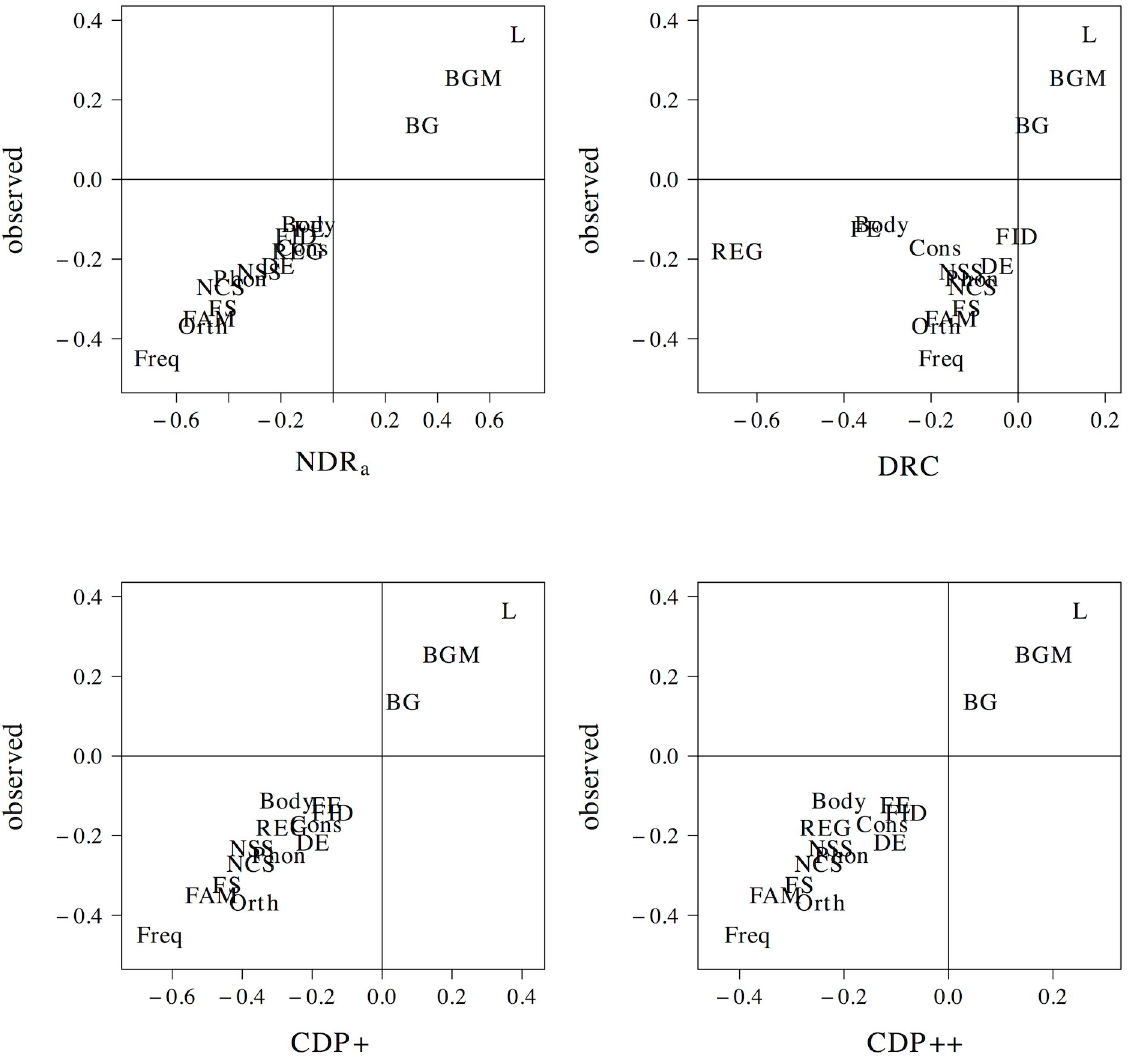
Fig 23. Predictor effect sizes. Comparison of predictor coefficients for the observed data and the simulations of the NDR (top right panel), CDP+ (bottom left panel), and CDP ++ (bottom right panel) models. Predictors from bottom to top: Freq (frequency), Orth (orthographic neighborhood density), FAM (familiarity), FS (family size), NCS (number of complex synsets), Phon (phonological neighborhood density), NSS (number of simplex synsets), DE (derivational entropy), REG (regularity), Cons (consistency), FID (frequency initial diphone), FE (friends-enemies measure), Body (body neighborhood density), BG (summed bigram frequency), BGM (mean bigram frequency), L (length).